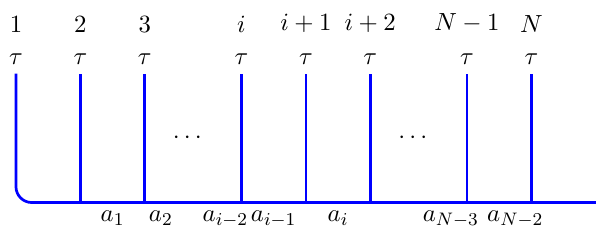
Figure 17 . Indexing of the anyons in the basis vectors with respect to the position of the fusing anyons. This indexing is important to index the local boson and fermion states of the supersym- metric Hilbert space. The anyon labels a are either 1 or τ . The anyon a i corresponds to c i c i +1 in the supersymmetric Hilbert space. Here c is either a local boson or a